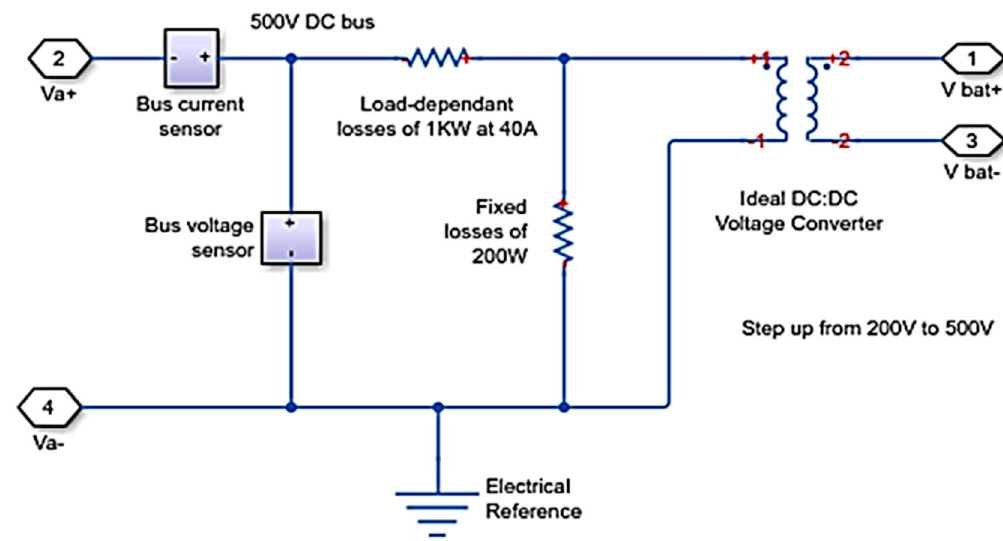
Figure 4. DC to DC converter